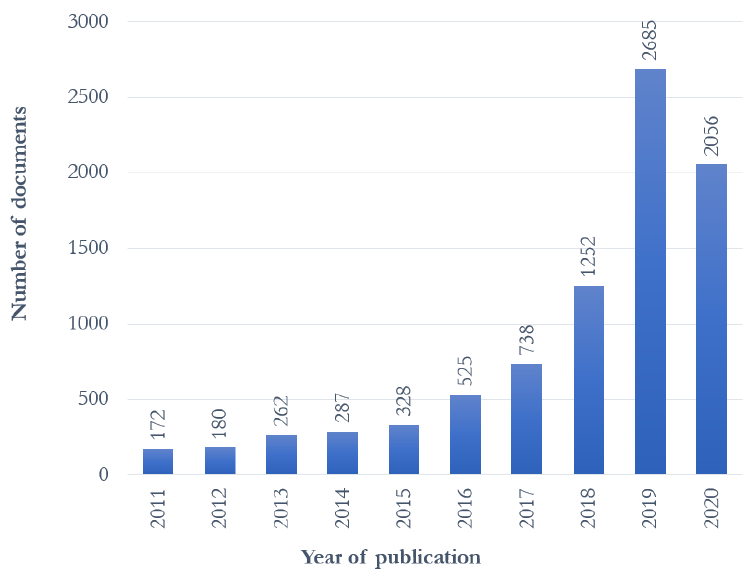
Figure 1. Distribution of the selected publications by year. In total, 8485 publications were collected from three digital repositories (Web of Science, ScienceDirect and Scopus) from 2011 to 2020, using the provided search